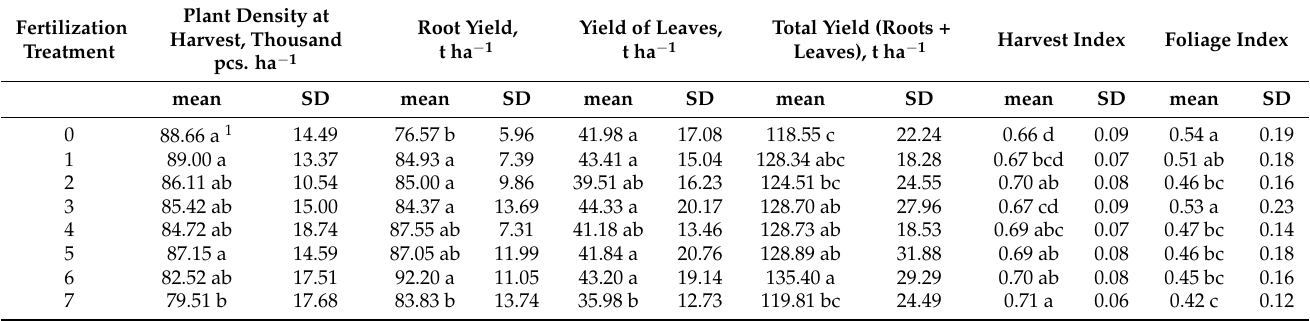
Table 1. Means and standard deviations (SD) for yield and yield-related traits of sugar beet (from 2018 to 2020). Plant Density at Fertilization Harvest, Thousand Treatment pcs. ha −